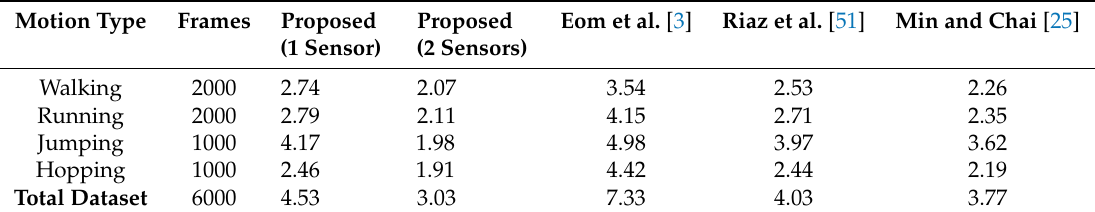
Table 3. Results obtained when evaluating the presented method with previously proposed solutions. The reconstruction error is measured in